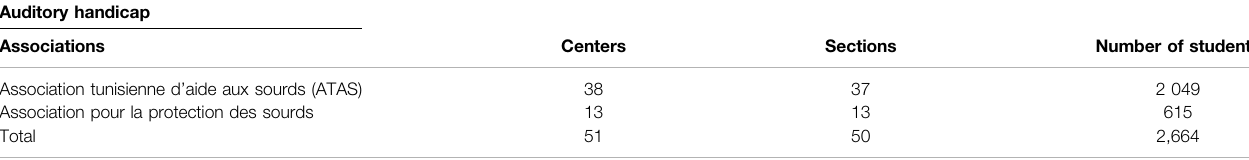
TABLE 2 | Distribution of special education and rehabilitation associations for the deaf 2009 (Initial report on Tunisia ’ s compliance with article 35 of the International Convention on the Rights of Persons with Disabilities 2010, 35). Auditory